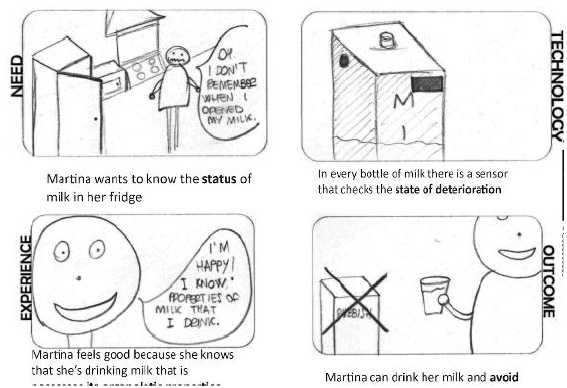
Fig. 14. Example of a tech functional scenario that presents the enabler in the form of a concept solution rather than of a prototype stimulus.